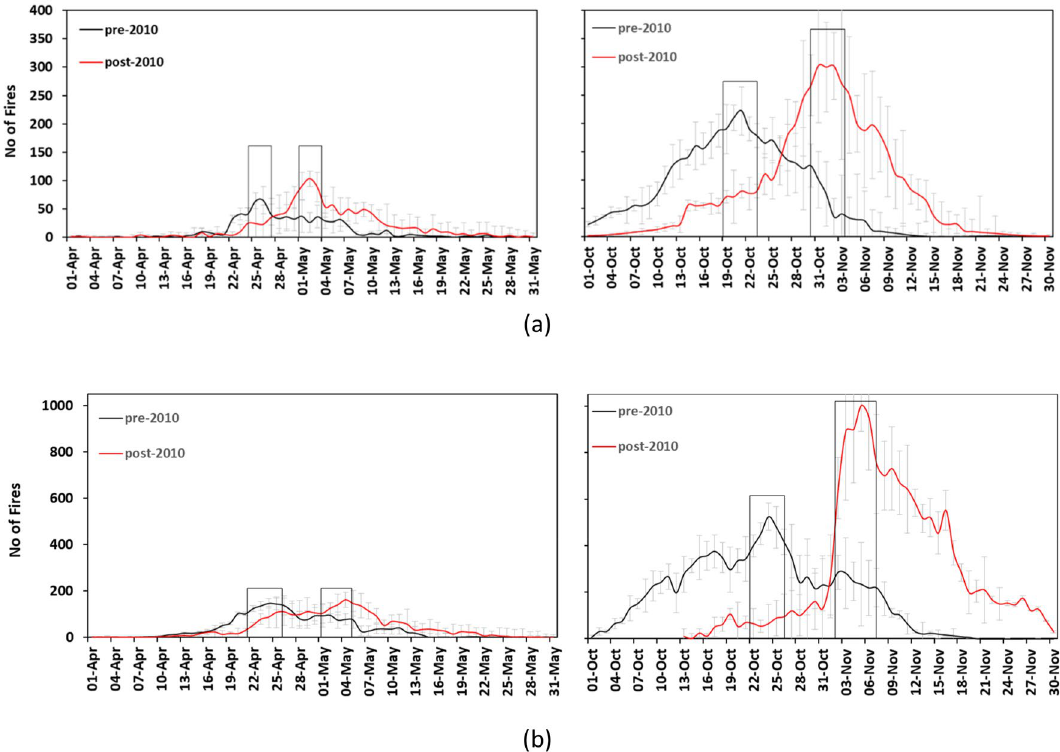
Figure 3. Daily average fire counts for PrM SB (left) and PoM SB (right) along with peak fire shift (in days) over Haryana ( a ) and Punjab ( b ) hotspot region during pre- and post-2010